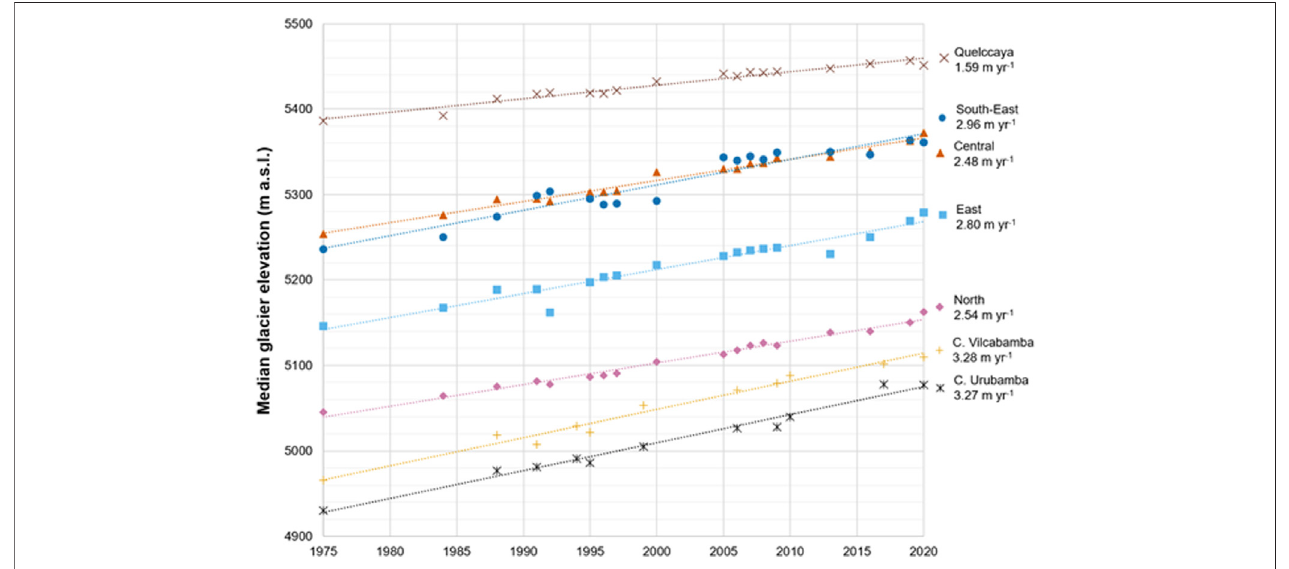
FIGURE 6 | Ice area change comparison to published studies over (A) The Cordillera Vilcanota and (B) The Quelccaya ice cap.